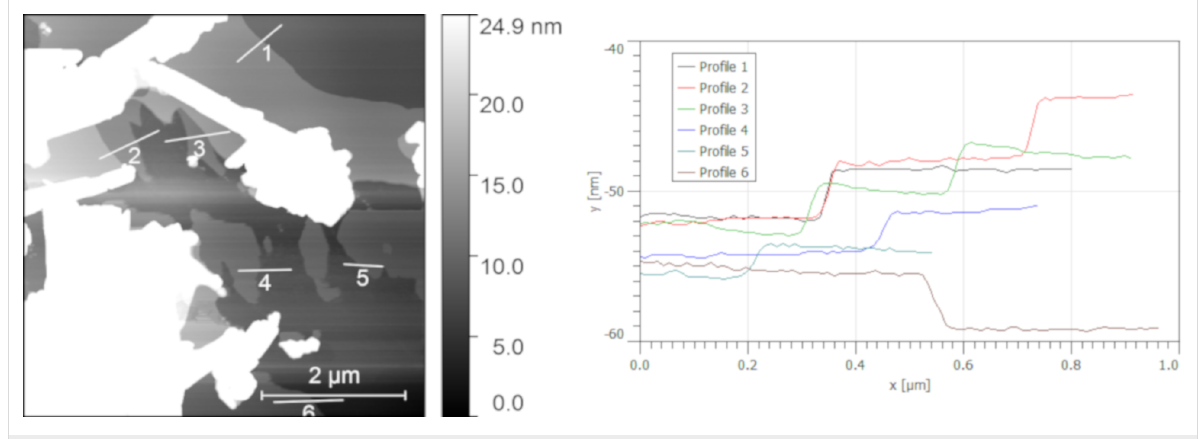
Figure 6: AFM topology scan of exfoliated CaPhP: monolamellar sheets (light gray areas), incompletely exfoliated particles (white areas) and line profiles (right) corresponding to the marked regions in the image to the left.